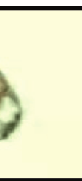
Figure 3: Cercariae (100 × ) of Paramphistomum spp. found in the snail belonging to the genus Lymnaea .